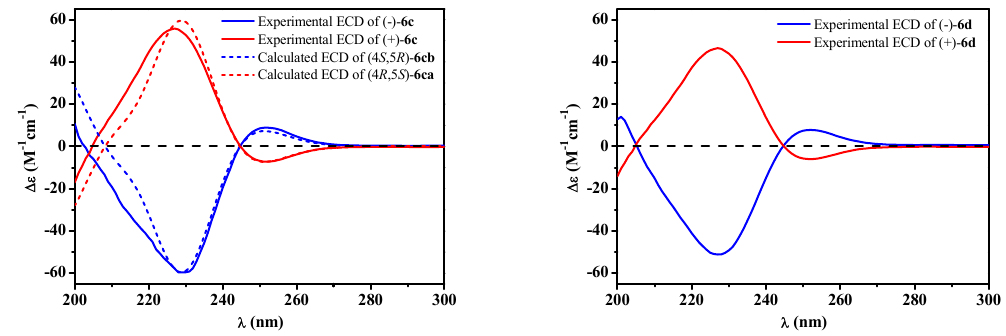
Figure 6. Experimental [( + ) / (–)- 6c , ( + ) / (–)- 6d ] and calculated [(4 S ,5 R ) / (4 R ,5 S )- 6c ] ECD spectra. Compound 7 was isolated as colorless blocks.